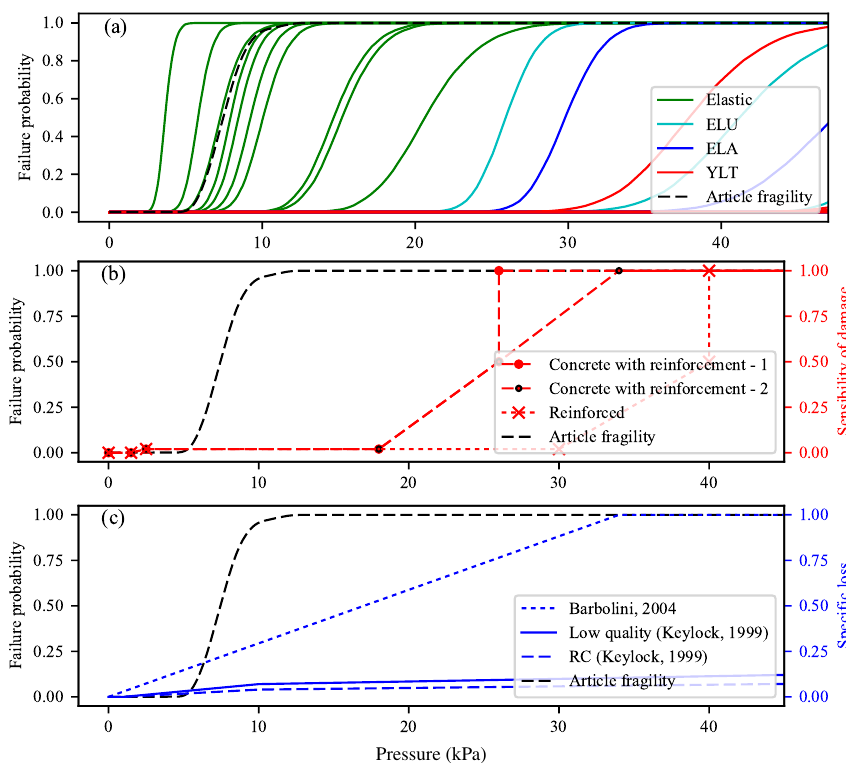
Figure 14. Comparison of the article fragility curve to (a) the numerical fragility curves from (Favier et al., 2014), (b) the expert judgmental fragility curves of (Wilhelm, 1998), and (c) the vulnerability curves of (Barbolini et al., 2004) and (Keylock et al., 1999). The exact meaning of each curve is provided in